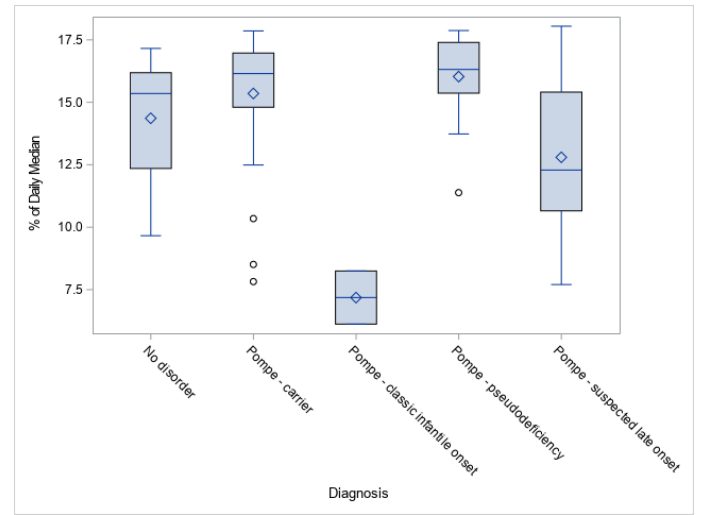
Figure 2. Acid alpha-glucosidase (GAA) activities (% of daily means) by resolution for positive Pompe disease screening.